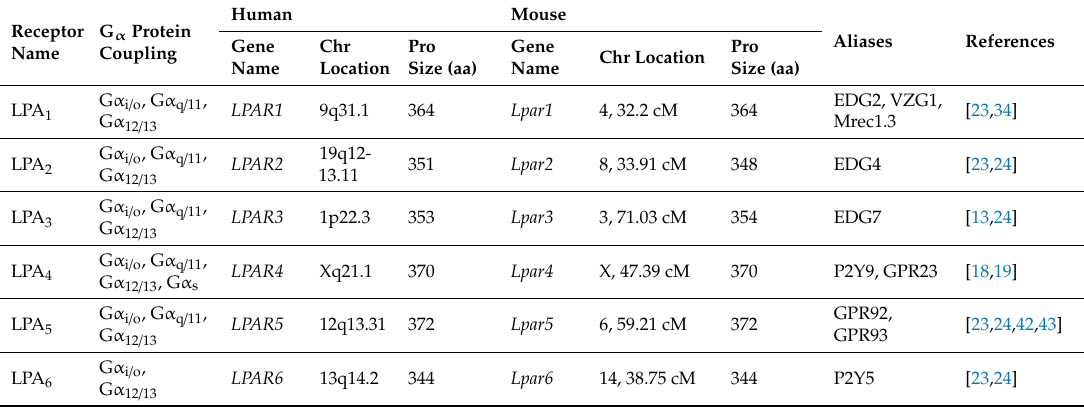
Table 1. LPA receptors in human and